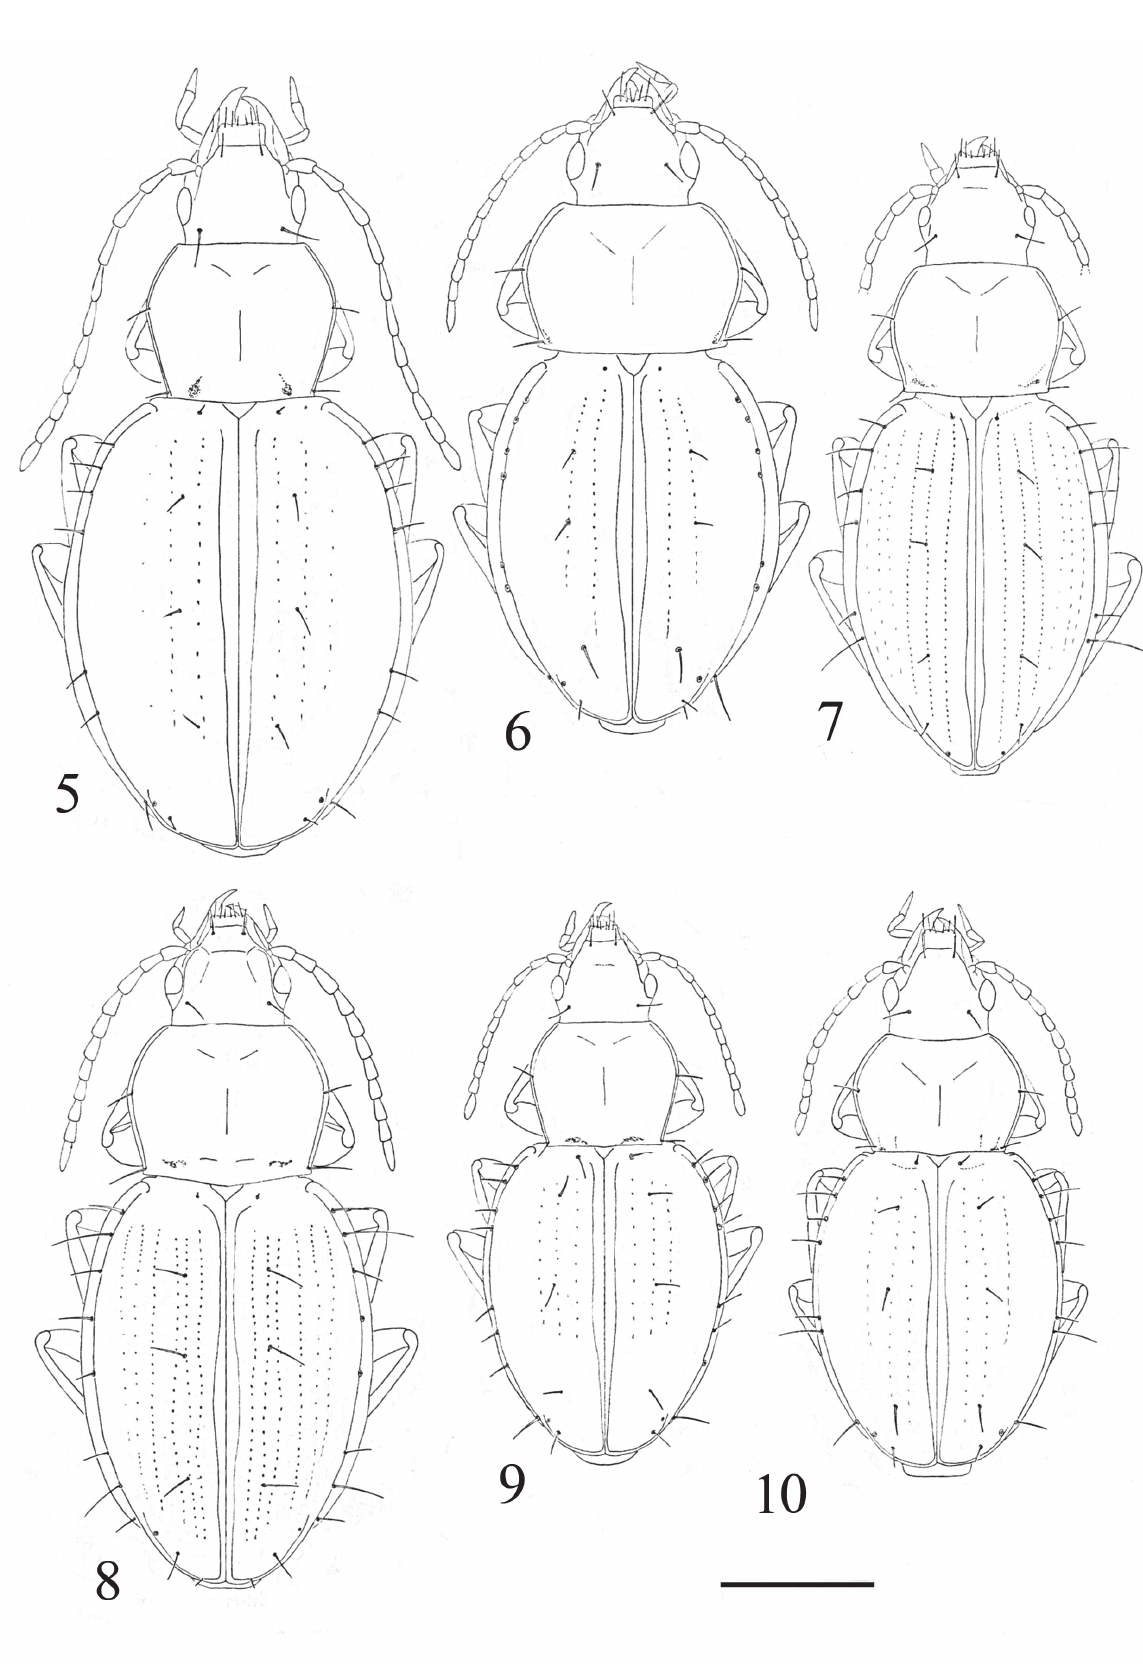
Figs 5-10. Habitus of Pterocyrtus spp.: 5) P. grayi sp. nov., HT ♀ from Elephant Farm Cave; 6) P. globosus Sloane, LT ♂ from Cradle Mtn.; 7) P. rubescens Sloane, HT ♂ from Waratah; 8) P. striatulus Sloane, LT ♂ from Cradle Mtn.; 9) P. tasmanicus (Castelnau), ♂ from Tasmania; 10) P. meridionalis sp. nov., HT ♂ from Lake Osborne. Scale: 1